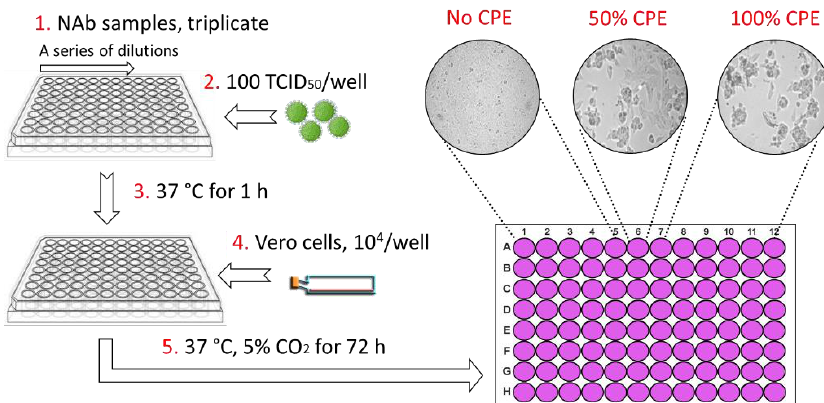
Figure 3. Anti-alphavirus neutralization titration assay. Serial 3-fold dilutions were made for each purified antibody in 50 µL. The virus (50 µL) was added to each well and then pre-incubated at 37 °C for 1 h. Thereafter, 1 × 10 4 Vero cells per well were added in a volume of 50 µL. Plates were then incubated for 3 days at 37 °C with 5% CO 2 and then examined under a microscope. The NAb titer was identified as the highest dilution that resulted in 50% inhibition of CPE caused by 100 TCID 50 .